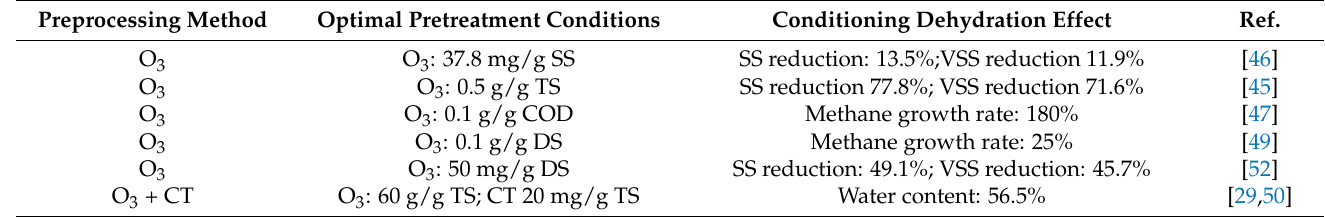
Table 3. Study results of enhanced sludge dewatering by ozone pretreatment.